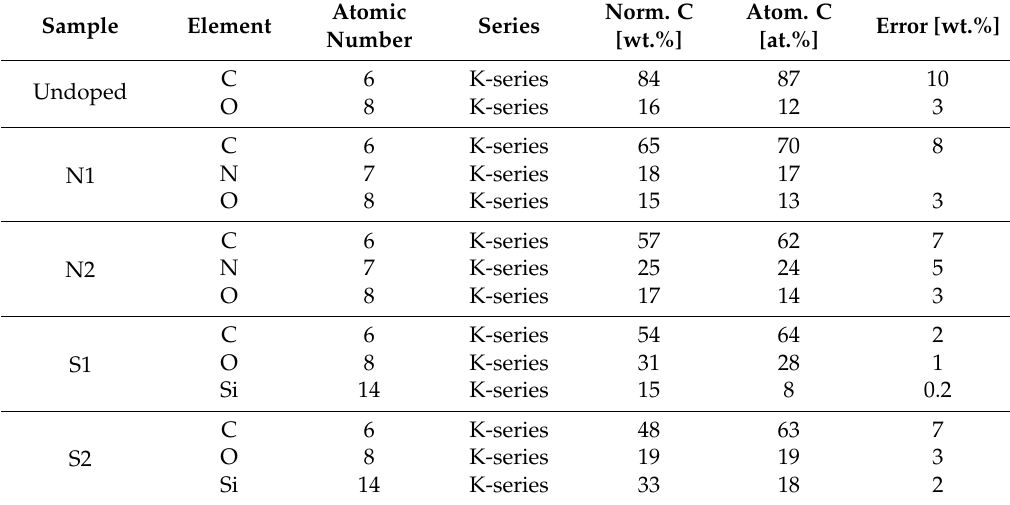
Table A1. Elemental composition of undoped, nitrogen- (Samples N1 and N2) and silicon-doped VOG coatings (Samples S1 and S2) obtained from the EDX